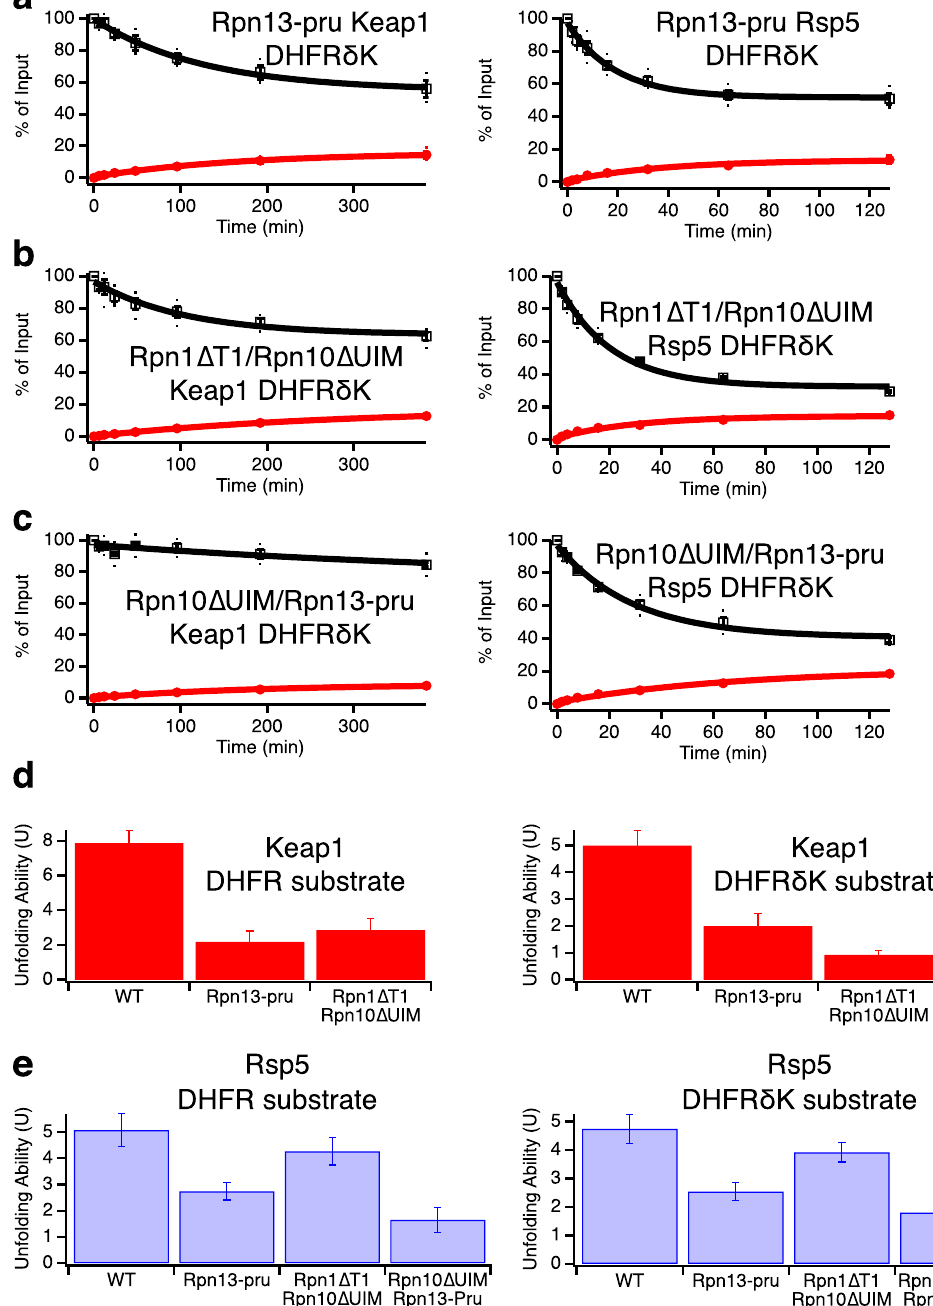
Figure 7. Ubiquitination on the DHFR domain does not affect differential dependence on ubiquitin receptors for Keap1 and Rsp5-ubiquitinated substrates. Degradation of trace radiolabeled Keap1- or Rsp5-ubiquitinated Neh2Dual-BarnaseL89G-3CPro-DHFR δ K-His substrate by 100 nM Rpn13-pru ( a ), Rpn1 ∆ T1/Rpn10 ∆ UIM ( b ), or Rpn10 ∆ UIM/Rpn13-pru ( c ) proteasome. The amounts of full-length protein (open squares) and DHFR fragment (red circles) are shown as a percentage of the full-length substrate presented to the proteasome at the beginning of the reaction. Dots are results from individual experiments, and error bars represent the SEM of 3–4 experiments (except for Keap1 Rpn10 ∆ UIM/Rpn13-pru, which was 2 experiments and did not show appreciable degradation, so no U was calculated). Curves are global fits to single exponentials. ( d , e ) Unfolding abilities (U) for Keap1 ( d ) and Rsp5 ( e ) substrates calculated from the curve fits shown in Fig. 6 and A-C for the DHFR δ K substrate compared to those for the DHFR containing substrate Neh2Dual-BarnaseL89G-DHFR-His from Fig. 4. Error bars are the SEM propagated from curve fitting the collected data sets. The relative effects of each ubiquitin receptor mutation were very similar regardless of whether DHFR could be